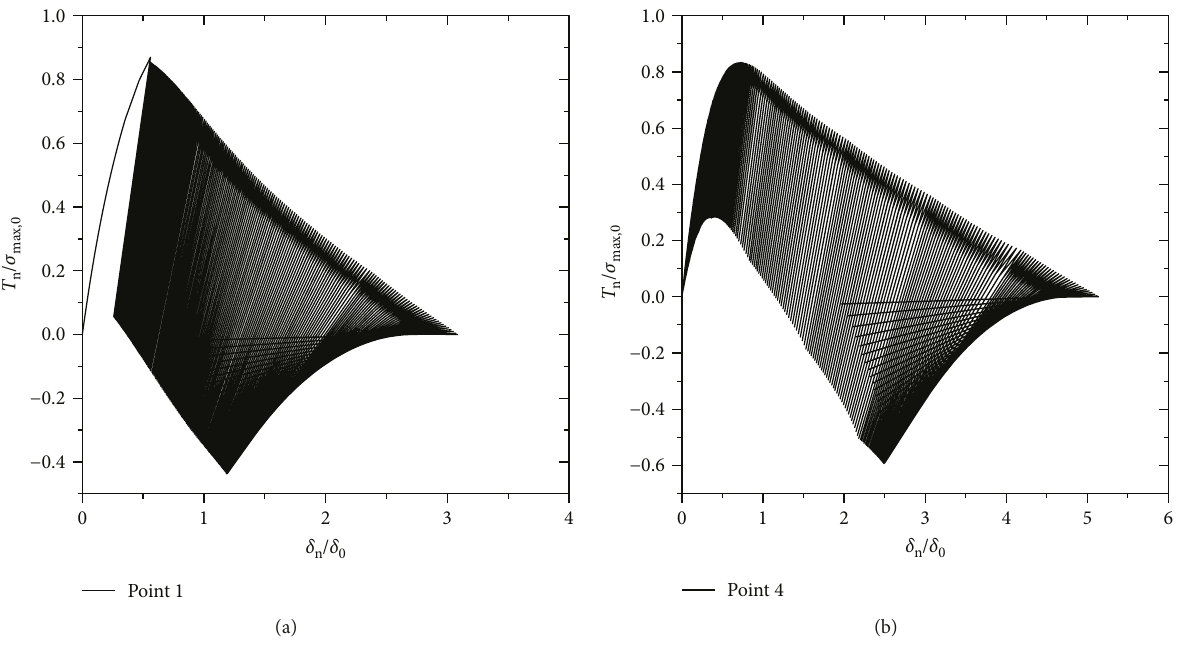
Figure 9: The traction versus separation curves are compared between (a) point 1 and (b) point 4, and the constant loading amplitude is carried out with F max = 24kN at R = 0 1 , which corresponds to the initial stress intensity factor range Δ K i = 76MPa m 1/2 for the CT specimen.